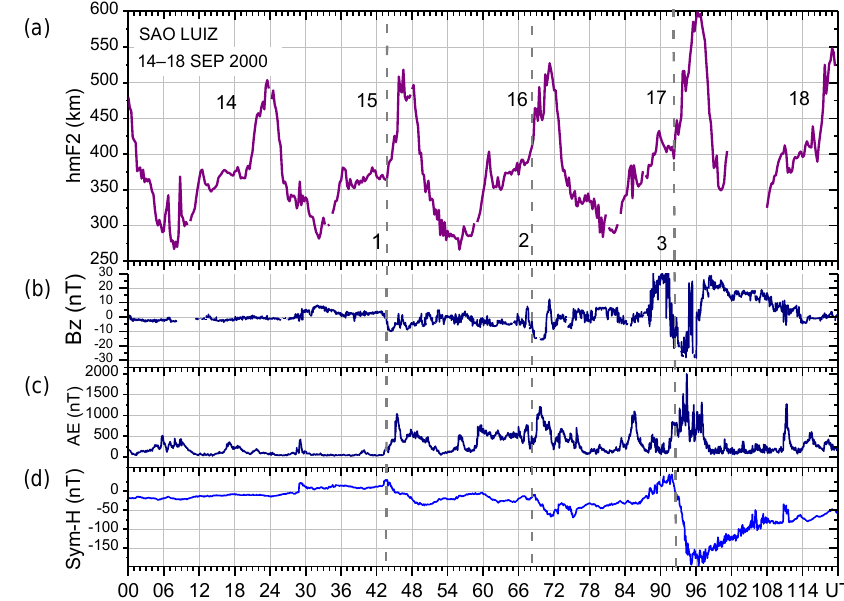
Figure 1. hm F2 variations over Sao Luis on 14, 15, 16 and 17 September 2000 (a) . The variations in B z (b) , AE index (c) and Asy-H/Dst (d) , for the same days.